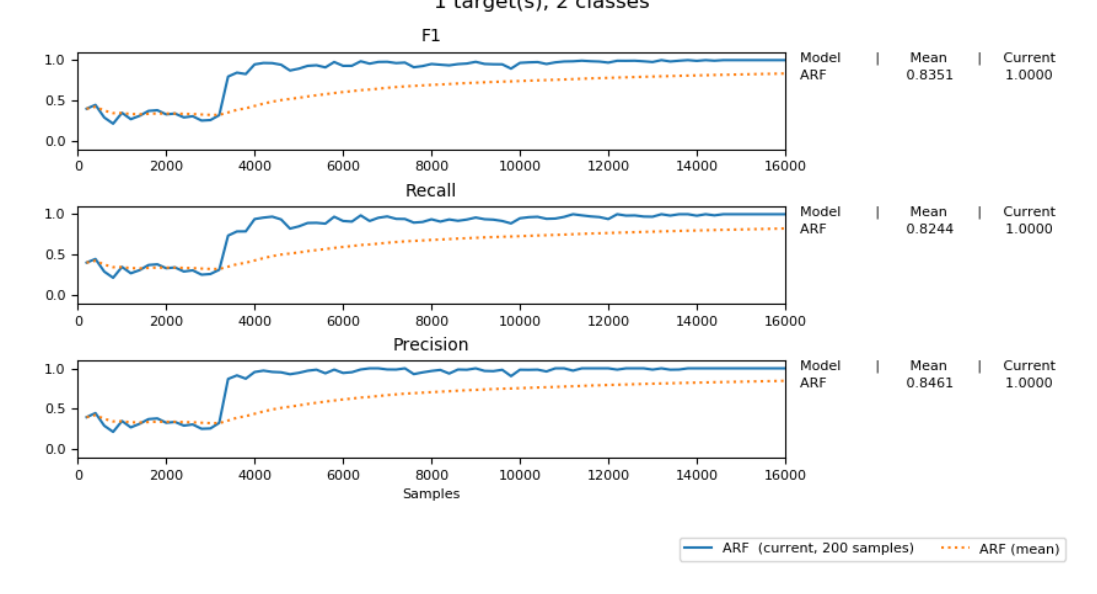
Figure 18. F1, Precision and Recall score of our predictive